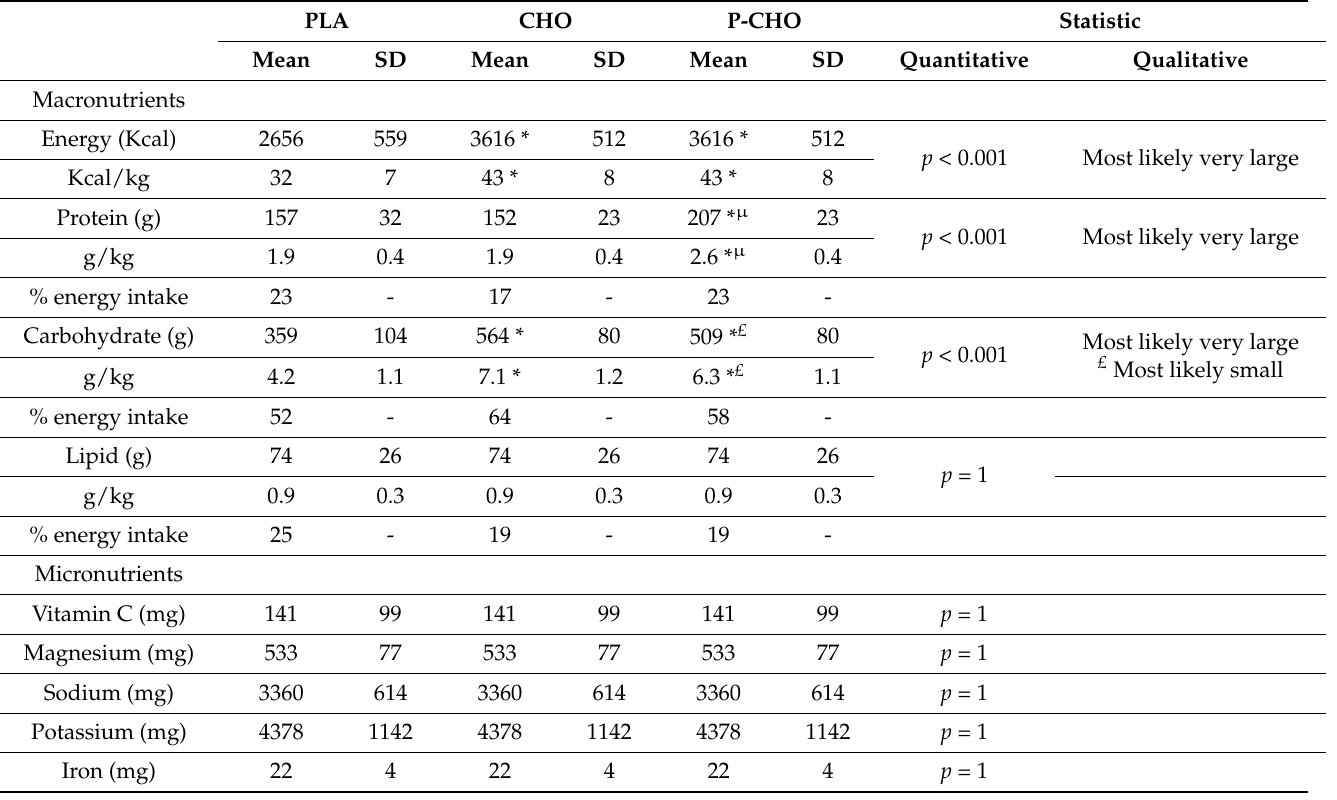
Table 1. Dietary intake during the rugby 7s tournament